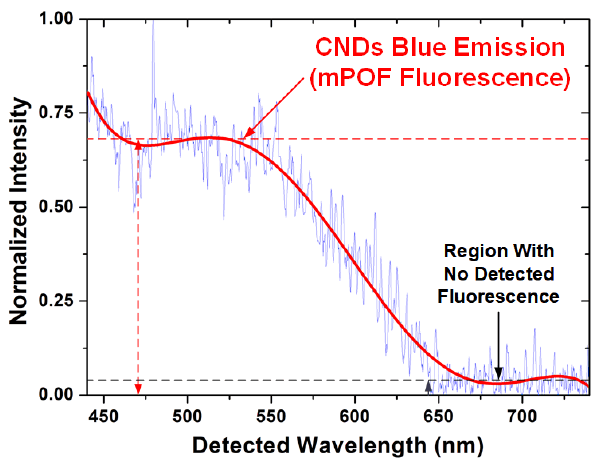
Figure 7. Fluorescence emitted by the mPOF with the composite of